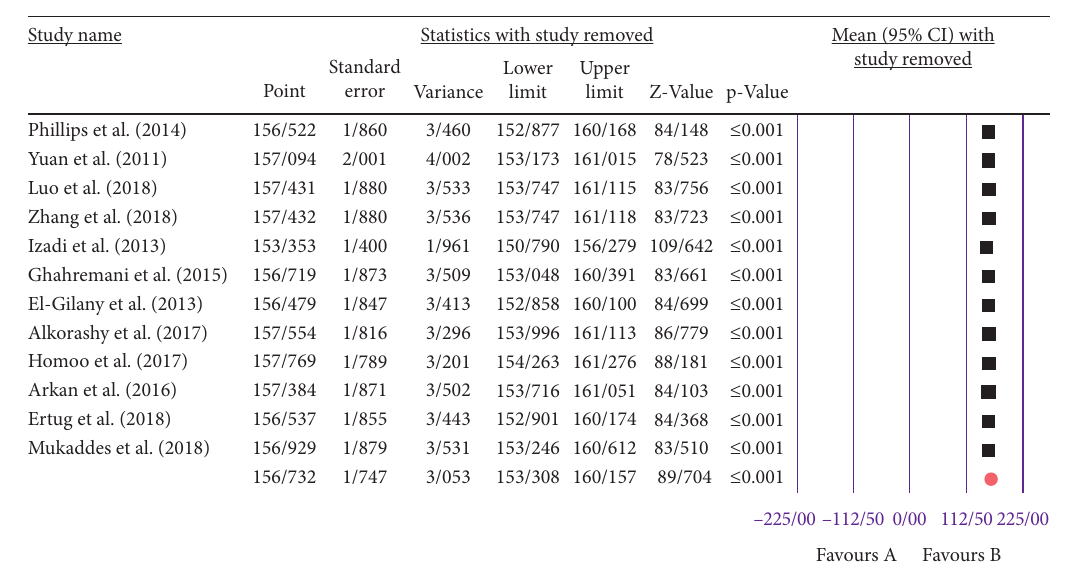
Figure 3: Results of sensitivity